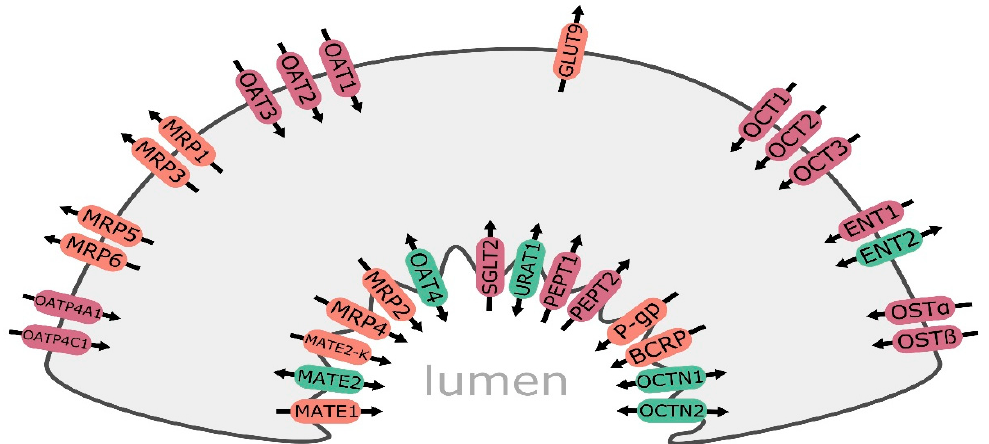
Figure 1. Major drug transporters in the kidney renal epithelial cell: ENT1—equilibrative nucleoside transporter 1; ENT2—equilibrative nucleoside transporter 2; GLUT9—facilitative glucose transporter 9; MATE1—multidrug and toxin extrusion protein 1; MATE2—multidrug and toxin extrusion protein 2; MATE2-K—multidrug and toxin extrusion protein 2 kidney- specific; MRP1—multidrug resistance-associated protein 1; MRP2—multidrug resistance-associated protein 2; MRP3— multidrug resistance-associated protein 3; MRP4—multidrug resistance-associated protein 4; MRP5—multidrug re-